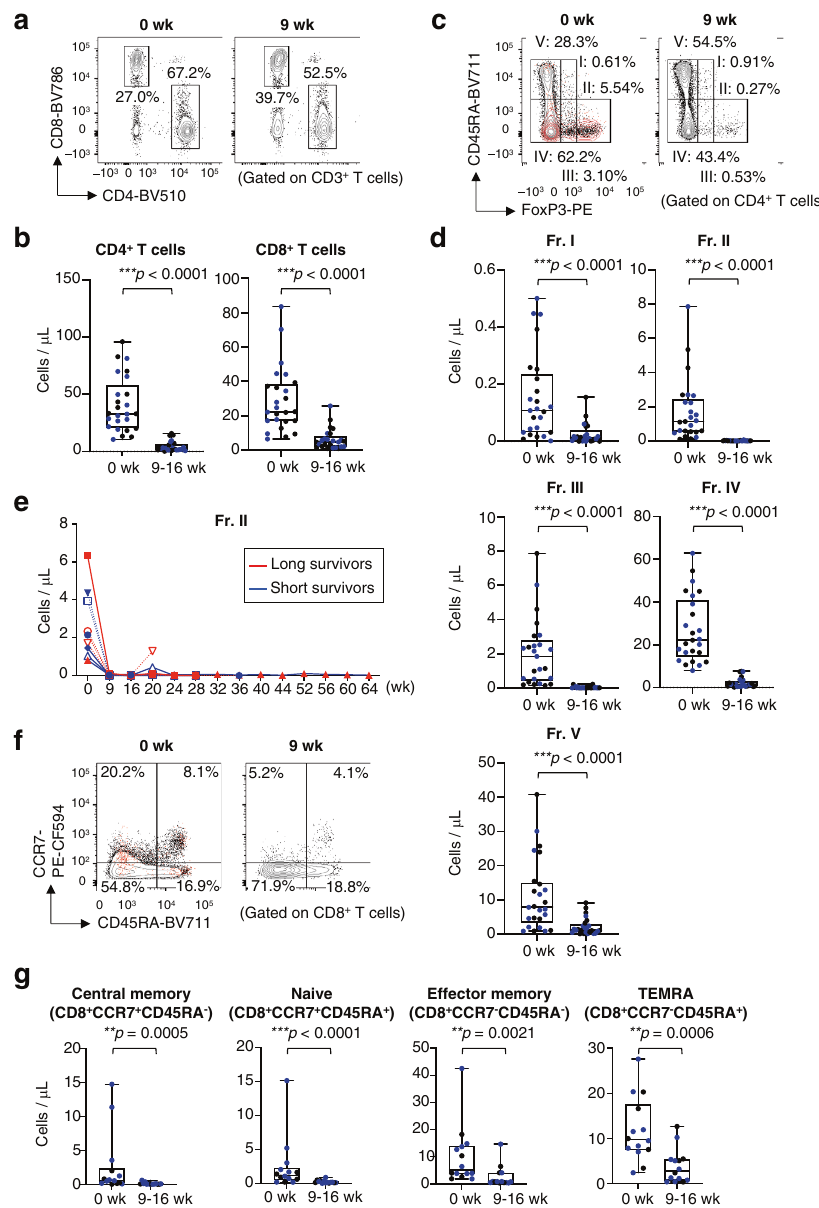
Fig. 2 Mogamulizumab treatment reduces all T cell subsets in the peripheral blood. a , b Representative fl ow cytometry staining for CD4 and CD8 in CD3 + T cells ( a ) and summaries for the absolute number of CD4 + T cells (*** p < 0.0001) and CD8 + T cells (*** p < 0.0001) at pre- and post- mogamulizumab treatment ( b ) are shown. PBMCs ( n = 25) obtained from pre- and post-mogamulizumab treatment. Pre-treatment samples were collected within two weeks before the initial mogamulizumab administration, and post-treatment samples were collected at 9-16 weeks after mogamulizumab administration and were subjected to fl ow cytometry. c Representative fl ow cytometry staining for CD45RA and FoxP3 in CD4 + T cells. Red dots, CCR4 + cells; black dots, CD4 + T cells. d Summaries for the absolute number of each CD4 + T cell fraction (Fr. I, *** p < 0.0001; Fr. II, *** p < 0.0001; Fr. III, *** p < 0.0001; Fr. IV, *** p < 0.0001 and Fr. V, *** p < 0.0001) as depicted in ( c ) at pre- and post-mogamulizumab treatment are shown ( n = 25). e . Longitudinal changes in the absolute number of Treg cells (Fr. II) in CD4 + T cells at pre- and post-mogamulizumab treatment are shown. Red lines, long survivors; blue lines, short survivors. f, g . Representative fl ow cytometry staining for CD45RA and CCR7 in CD8 + T cells ( f ) and summaries for the absolute number of each CD8 + T cell fraction (Central memory, ** p = 0.0005; Naive, *** p < 0.0001; Effector memory, * p = 0.0021 and TEMRA, ** p = 0.0006) as depicted in ( f ) at pre- and post-mogamulizumab treatment ( g ) are shown ( n = 14). Red dots, CCR4 + cells; black dots, CCR4 - cells. In ( b , d and g ), black dots, patients who received 1.0 mg/kg mogamulizumab; blue dots, patients who received 0.1 mg/kg mogamulizumab and two-sided Mann – Whitney test was used. In ( b , d and g ), the center line indicates the median, and the box limits indicate the 1st and 3rd quartiles. The whiskers go down to the smallest value and up to the largest. week: wk, naive CD8 + T cells: Naive, central memory CD8 + T cells: Central memory, effector-memory CD8 + T cells: Effector memory, TEMRA CD8 + T cells: TEMRA, * p < 0.01, ** p < 0.001, *** p < 0.0001. Source data are provided as a Source Data fi